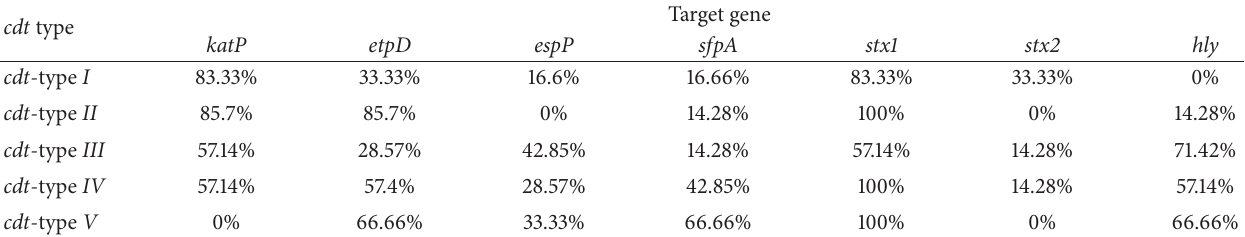
Table 3: The frequency of target genes in different cdt -type